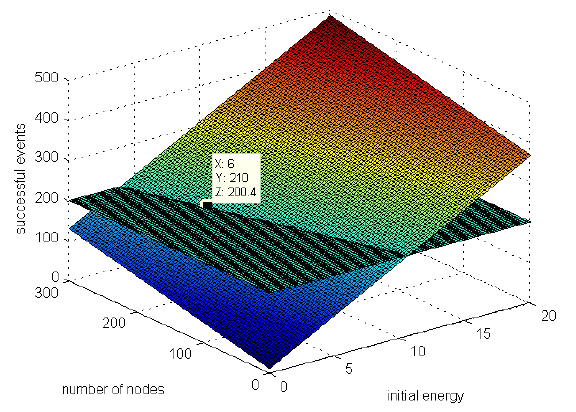
Fig. 13. Mean value for the number of successful events for EAST with neighborhood discovery as a function of the number of deployed nodes and the node initial energy with an intersecting plane with the value 200 successful events